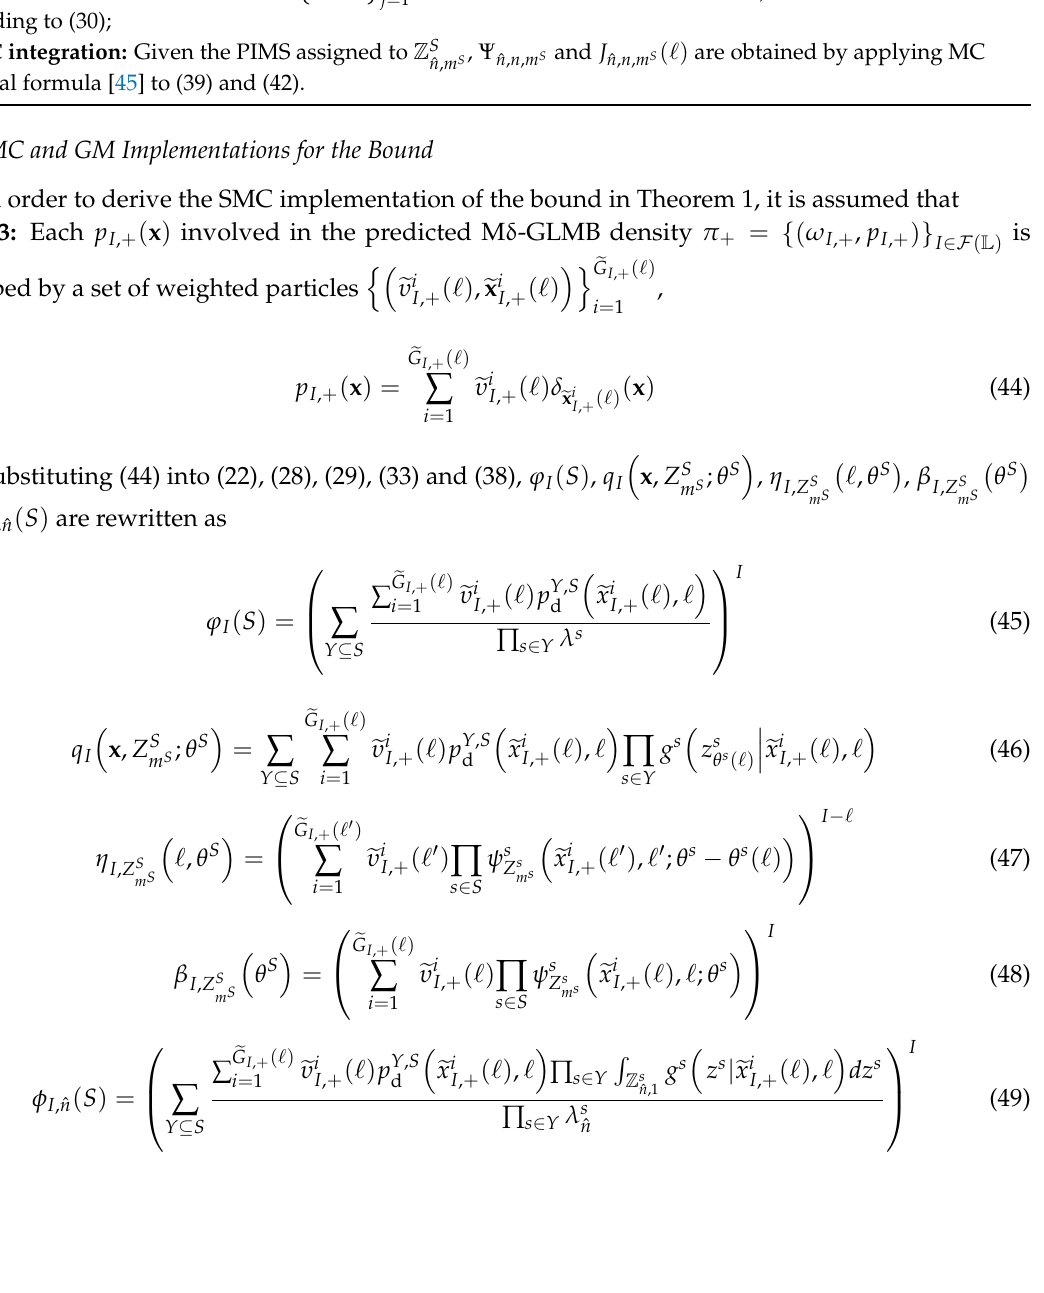
( (cid:96) ) J ˆ n , n , m S and , n , m S